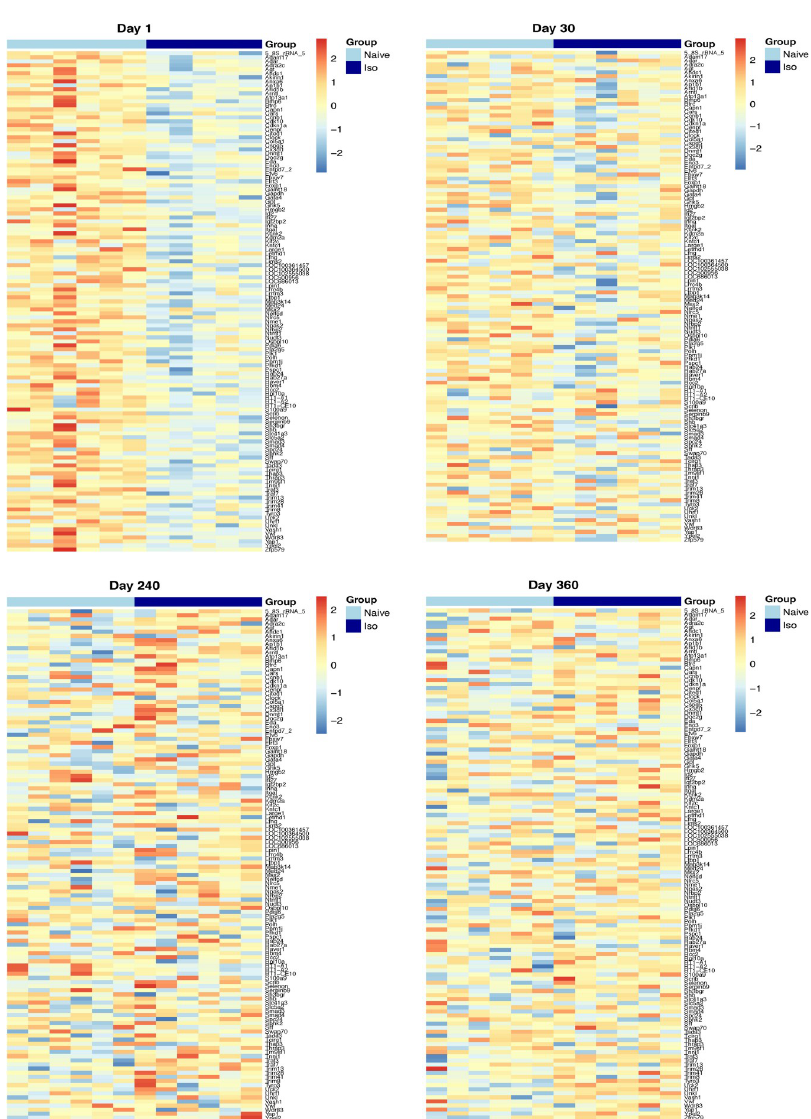
Fig 9. Heatmaps of the 125 “down” genes reflecting short-term effects of repeated acute ISO exposures. Heatmaps generated for the 125 down-regulated genes which were either in wound-related pathways with a p < 0.05 at Day 1, or a p < 0.1 and changing in same direction at both Day 1 and Day 30. Top left shows Day 1, top right shows Day 30, bottom left shows Day 240, and bottom right shows Day 360. The light blue represents samples from the na ï ve group; dark blue represents samples from the ISO group. Groups of rats exposed to air (na ï ve, n = 6/each timepoint group) or ISO (n = 5/Day 1 group, and n = 6/Day 30, 240, and 360 groups) were